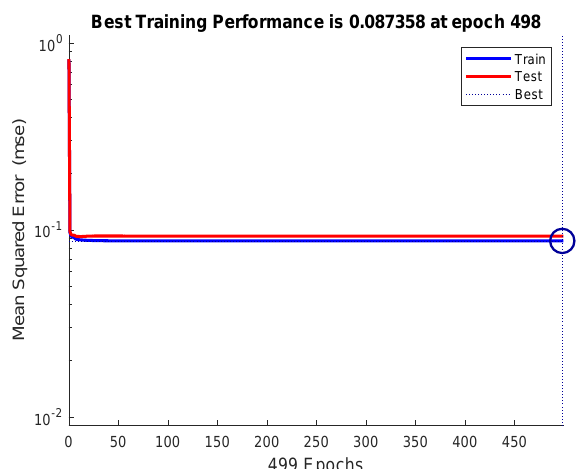
Figure 17. The mean-squared-error for the training and testing of the power allocation module.